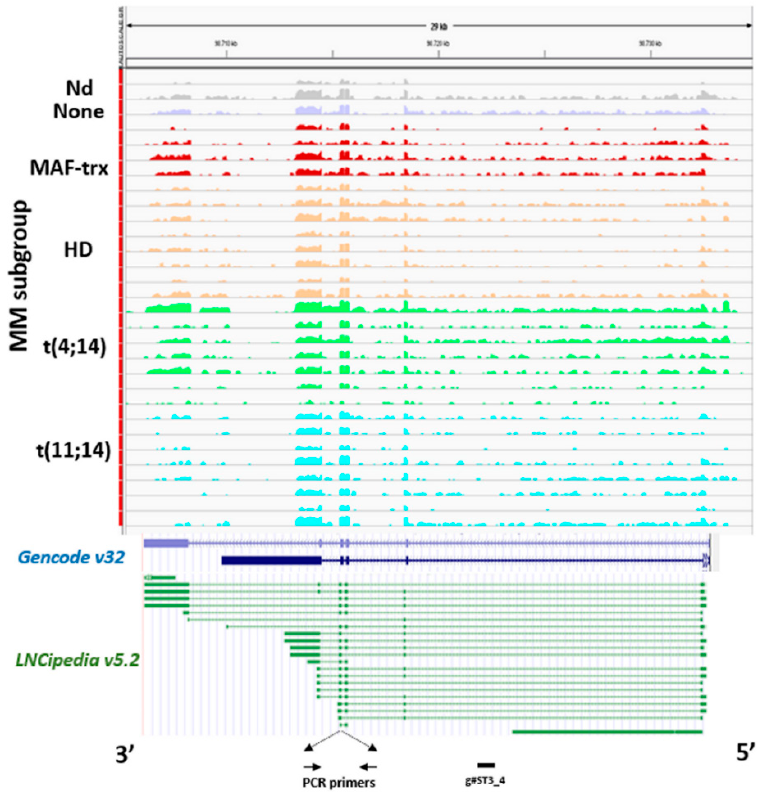
Figure 2. Analysis of ST3GAL6-AS1 expression. ST3GAL6-AS1 expression by RNA-sequencing. Visualization of RNA-seq data: zoomed view of the ST3GAL6-AS1 lncRNA region; the coverage bigWig files generated using bamCoverage function in deeptools [23] and the human genome annotation file (GENCODE v.32) were loaded into the Integrated Genome Viewer [24]. FANTOM CAT transcripts included in LNCipedia repository are also reported. The y-axis shows the scaled number of reads mapping to each location of the genome in the ST3GAL6-AS1 region (x-axis) schematically reported. Each lane represents a MM patient: different colors refer to the sample molecular characteristic indicated at the left. In order to compare samples, coverage values from all patients were group-scaled. Localization of primers used in RT-PCR analysis and g#ST3_4 gapmeR used for functional study is also indicated at the bottom.